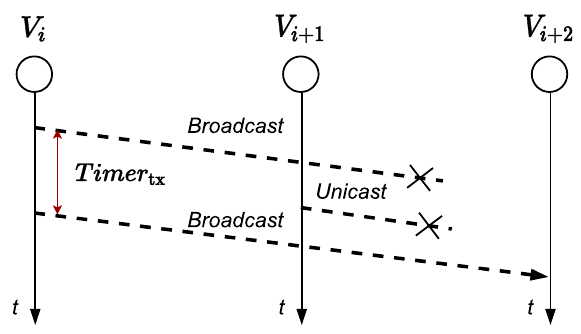
Figure 7. Frame does not reach node v i+2.